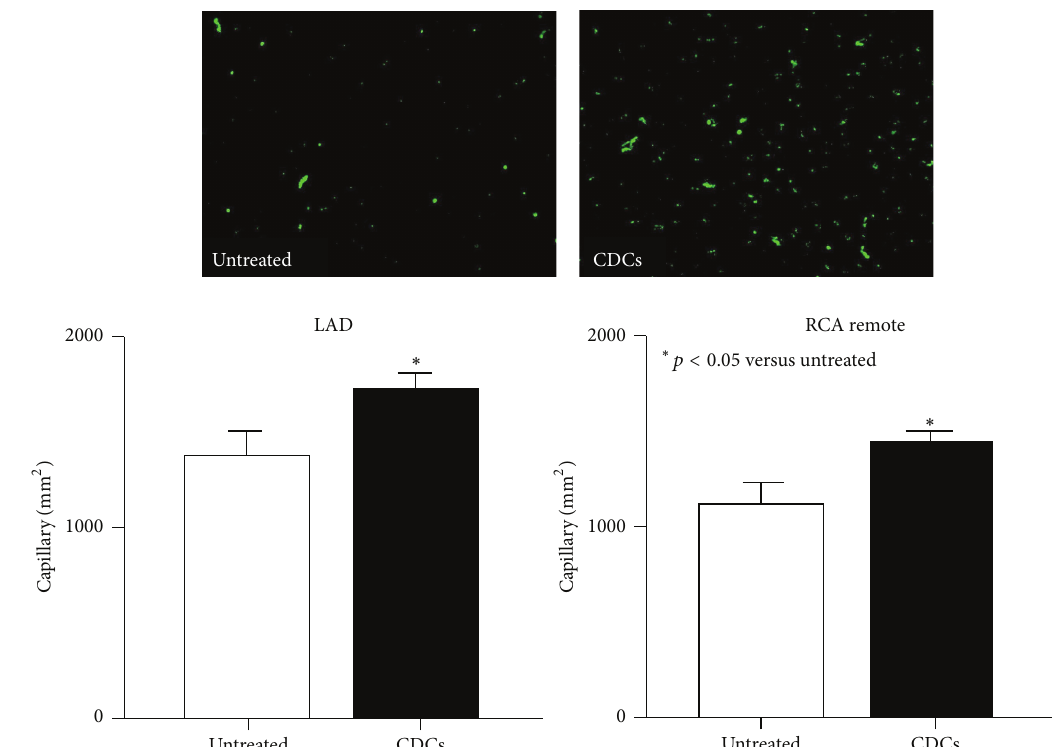
Figure 8: The effect of CDCs on capillary density. The upper panel represents images of capillary vessels stained with von Willebrand in ischemic myocardium. vWF positive cells were localized with capillary vessels as shown in green. DAPI nuclei are in blue. The lower graphs summarize the number of vWF positive capillaries (number per mm 2 ). CDCs increased capillary density indicating angiogenesis. These data indicate that CDCs increased angiogenesis as well as myocyte regeneration in swine with ischemic